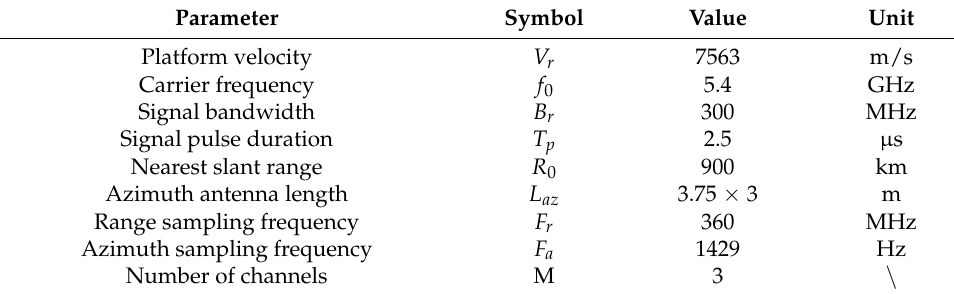
Table 1. Simulation system parameters.